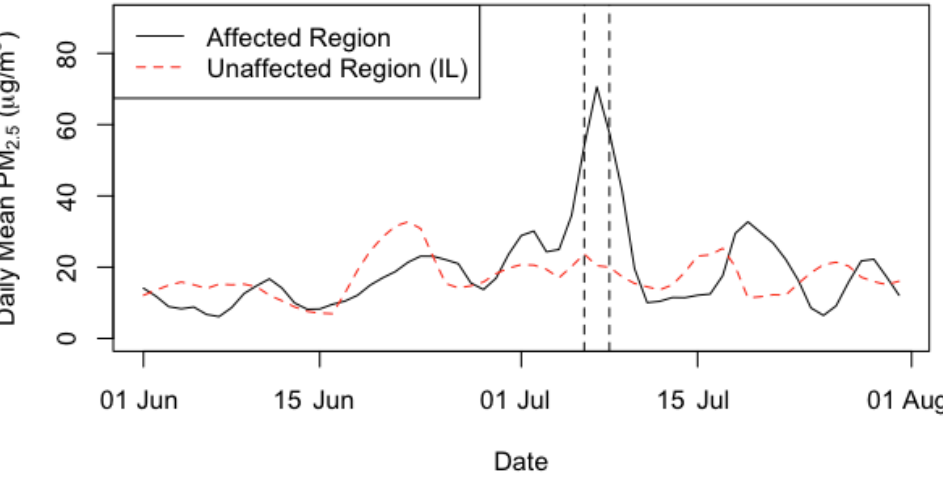
Figure 2. Countywide daily mean PM from 1 June to 31 Jul